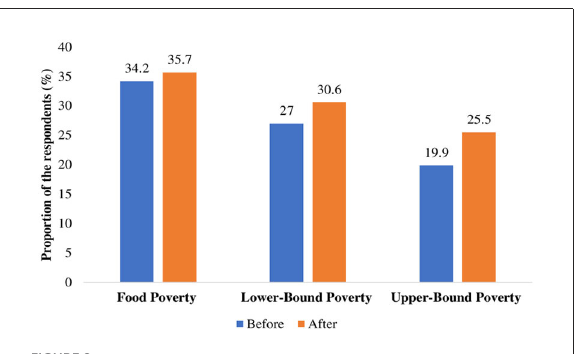
FIGURE2 Poverty status of the respondents before and after receiving support from the Ilima-Letsema programme ( n = 196).